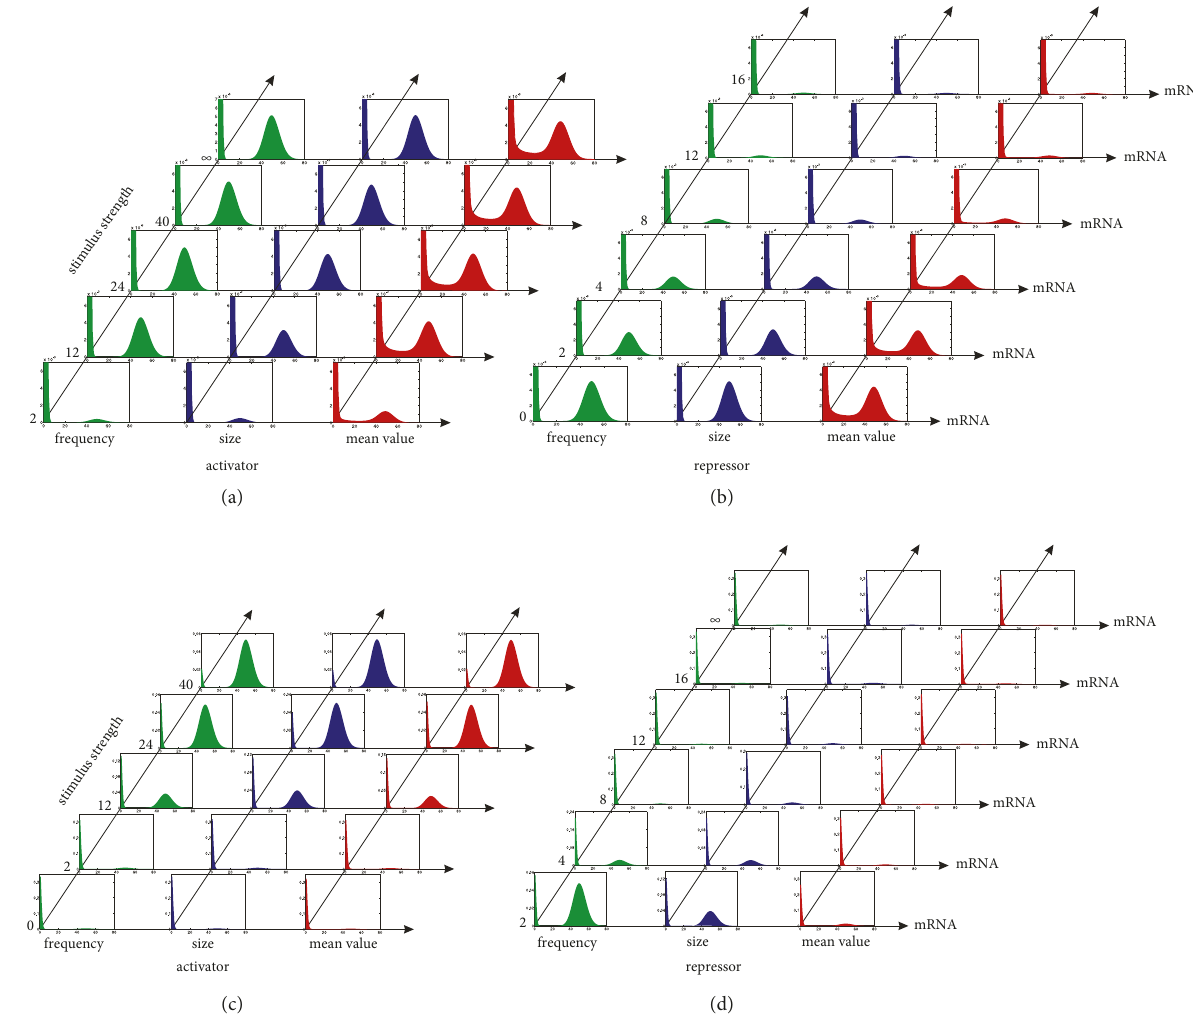
Figure 7: Dependence of mRNA distribution on the upstream signal of role and stimulus strength: (a, b) FM paradigm; (c, d) AM paradigm; (a, c) activator; (b, d) repressor. The green drawing represents the upstream input as the frequency signal, the blue drawing represents the upstream input as the amplitude signal, and the red drawing represents the noiseless input. Other parameter values are set as k k � 0 . 1, k � 10, n � 2, λ � 1, and λ � d off 0 1